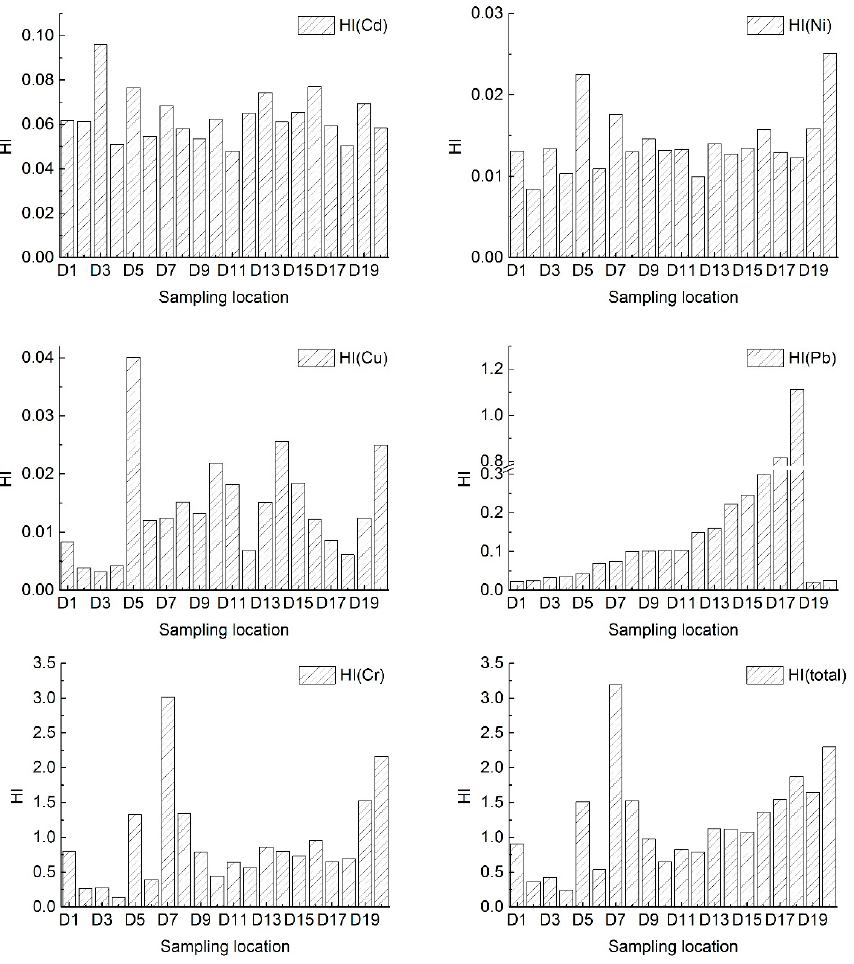
Figure 2. Non-carcinogenic risk value (child) of heavy metal in leisure squares of Yanta District in Xi’an.